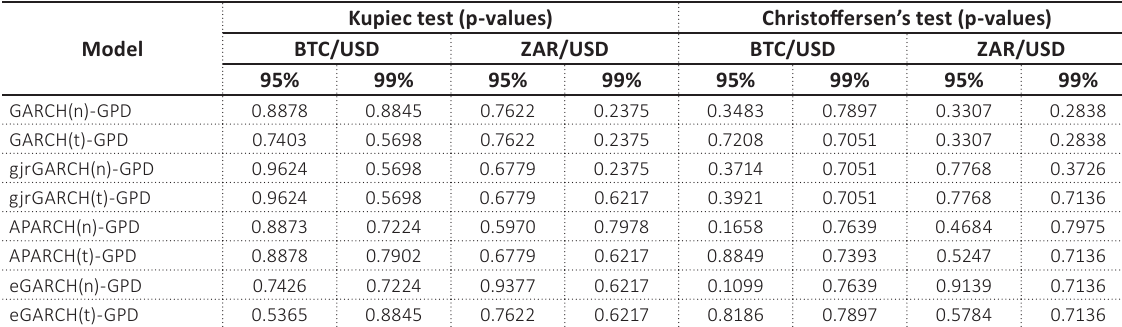
Table 7. Backtest results for VaR estimates using fitted